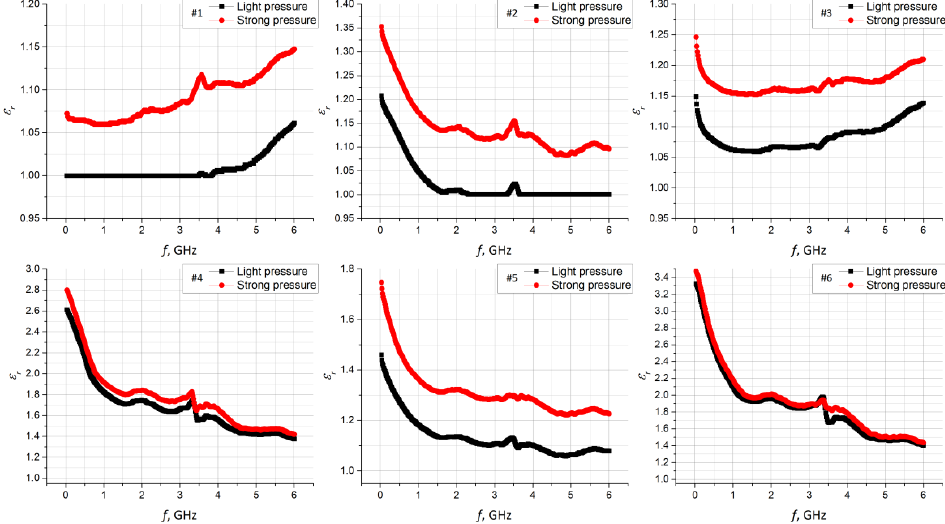
Figure 8. Comparison of ε r for light and strong pressure on substrate samples.